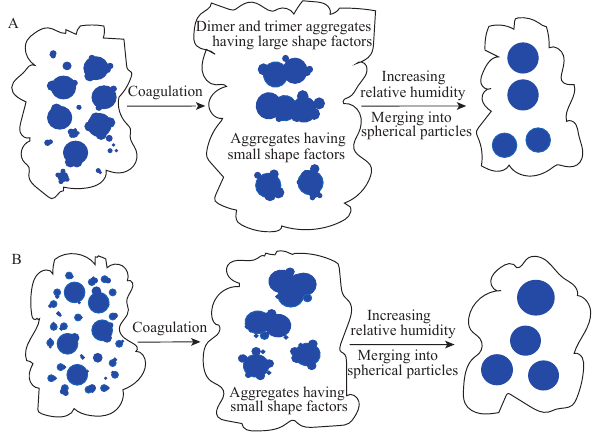
Figure 3. Diagram representing changes in particle shape due to coagulation and to elevated relative humidity. (a) Scenario for an experiment using a medium concentration of α -pinene (700ppb) in which two similarly sized particles collide to form dimer and trimer agglomerates, leading to relatively larger dynamic shape fac- tors (rightmost to middle column). They constitute < 0.25% of the total particle population. They become nearly spherical after expo- sure to an elevated RH (middle to leftmost column). The elevated RH decreases viscosity and allows material flow. (b) Scenario for an experiment using a high concentration of α -pinene (1000ppb), in which several particles collide to form larger agglomerates hav- ing relatively smaller dynamic shape factors. At elevated RH, these particles also flow and become